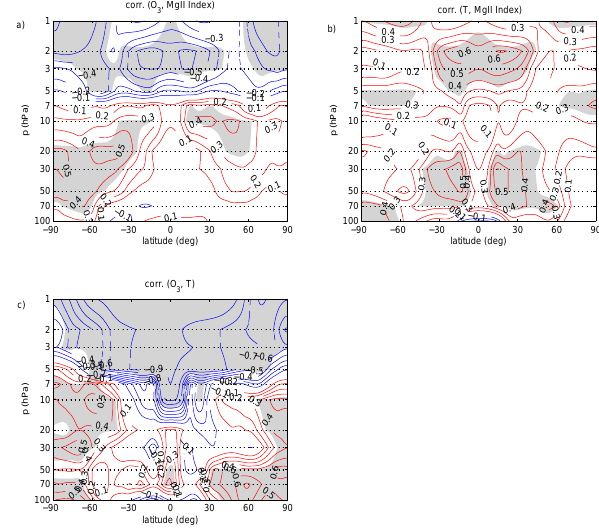
Figure 6. Maps of Pearson’s linear correlation coefficients between (a) the annual, zonally averaged O 3 and Mg II index, (b) T and Mg II index, and (c) O 3 and T . Shaded areas denote statistically significant correlations at the 95%